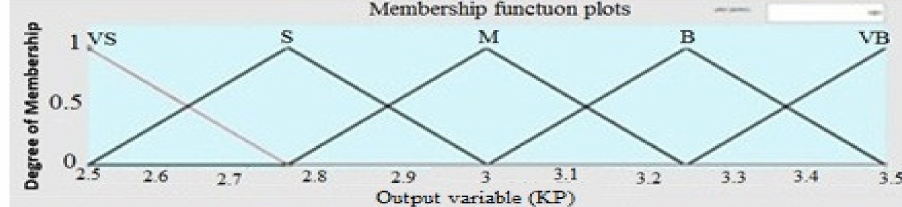
Figure 4. Direct and quadrature current variation of error ( ∆∆ Id and ∆∆ Iq). Membership functions for the fuzzy-PI inverter control.